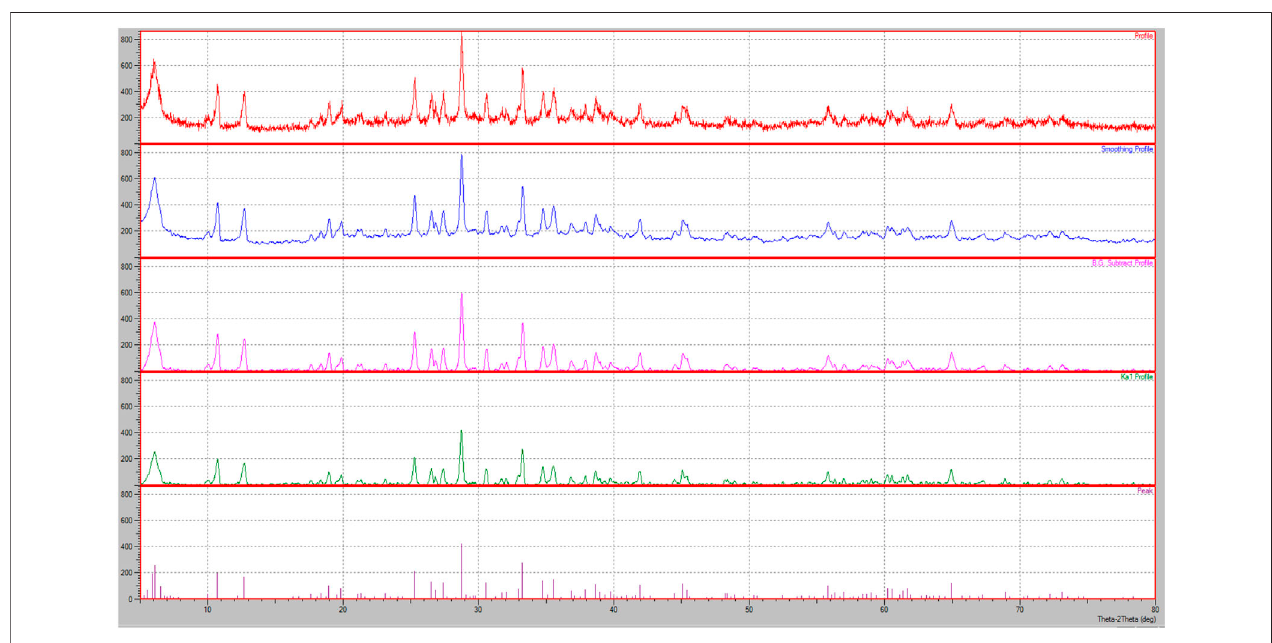
FIGURE 9 | Malachite sample diffractogram.